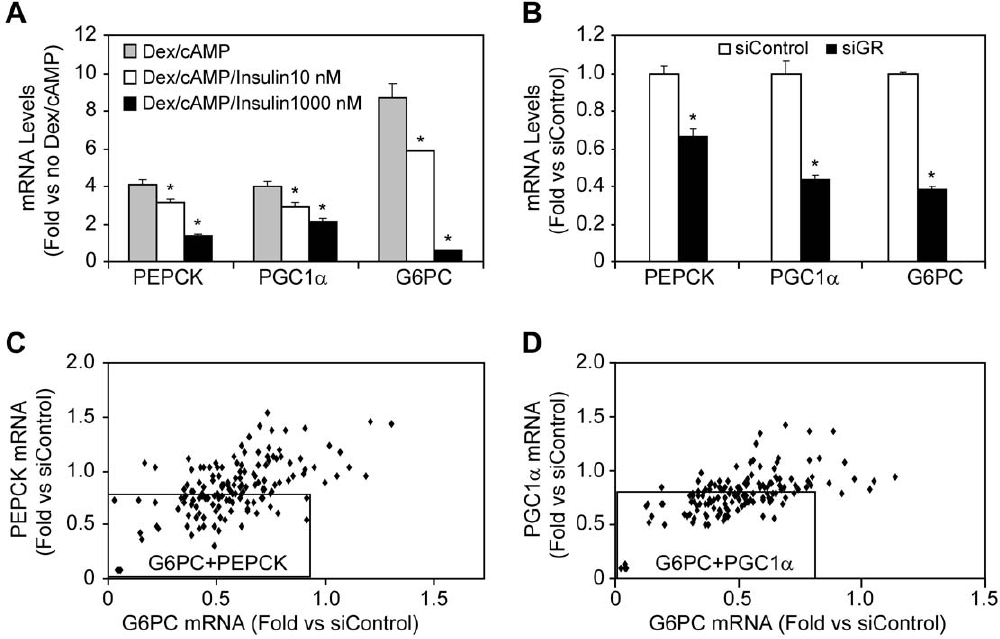
Figure 5. Use of a multiplex HTG assay to identify confirmed hit siRNA pools that decrease expression of key gluconeogenic genes in addition to G6PC. A. Dex/cAMP increases and insulin dose-dependently reduces AH-G6PC cell PEPCK, PGC1 a , and G6PC mRNA expression. Data are presented as the means 6 SEM of fold change relative to untreated cells in 3 independent experiments. B. Knockdown of GR by siRNA significantly reduces PEPCK, PGC1 a , and G6PC mRNA in AH-G6PC cells incubated with Dex/cAMP and 10 nM insulin. Data are presented as the means 6 SEM of fold change relative to mRNA expression in siControl-transfected cells in 3 independent experiments. C. Subsets of pooled siRNAs targeting confirmed hits regulate G6PC and PEPCK, or D. G6PC and PGC1 a mRNA expression, in AH-G6PC cells treated with Dex/cAMP and 10 nM insulin. Data in Figures 5C and 5D are plotted as fold change relative to mRNA expression in siControl-transfected cells and are the means of 3 independent experiments. The squares contains siRNAs that reduced both G6PC and PEPCK (C) or G6PC and PGC1 a (D) expression by 20% and 15%, respectively.